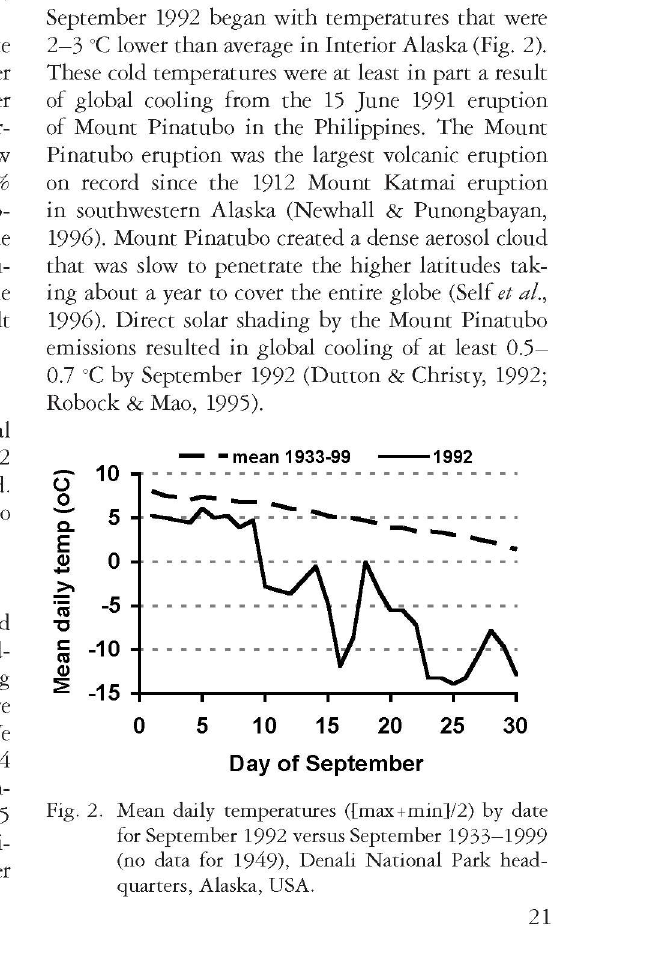
Fig. 2. Mean daily temperatures ([max+min]/2) by date for September 1992 versus September 1933—1999 (no data for 1949), Denali National Park head quarters, Alaska,